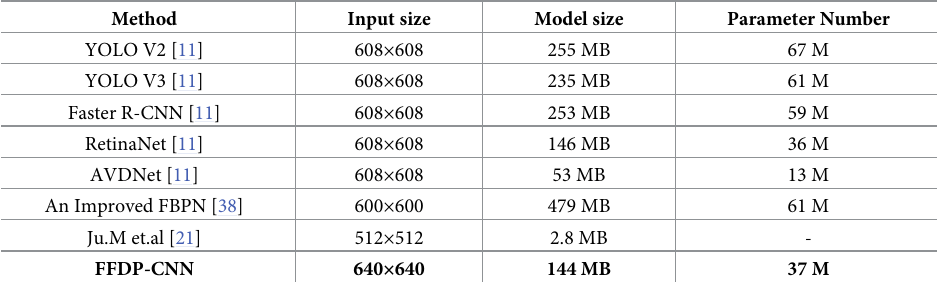
Table 9. Comparison of parameter numbers and other information.